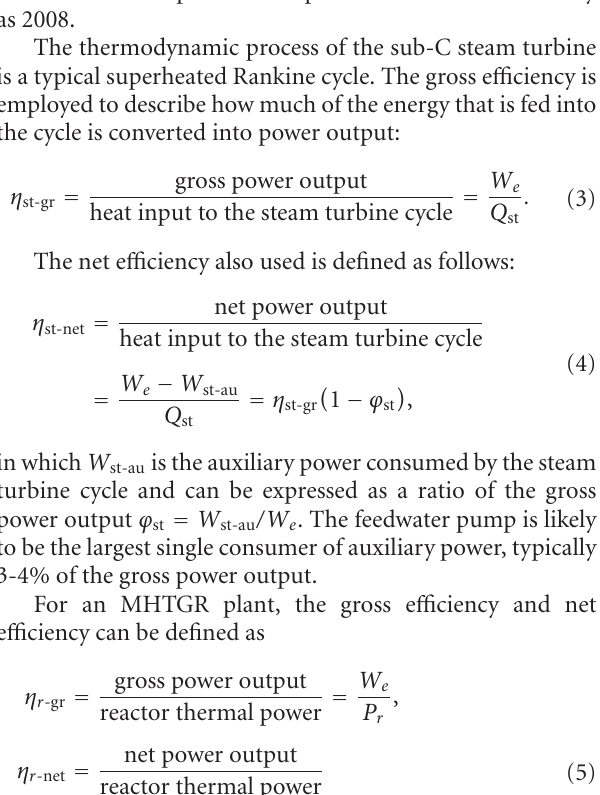
e ffi ciency: reheat of steam and regeneration of